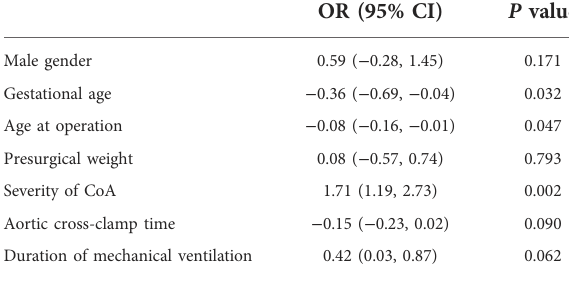
TABLE 3 Multiple linear regression analysis of the different predictors of total length of ICU stay.